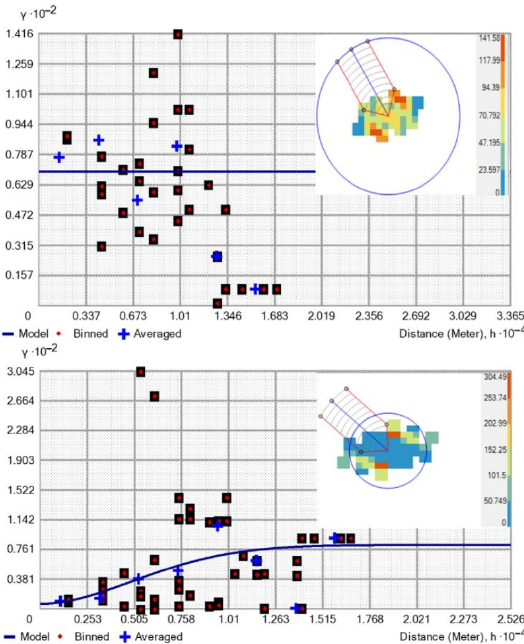
Figure 16. The empirical semivariograms with averaged values (fitted models by solid lines) and semivariogram maps of the ordinary kriging method from the dataset for the vegetation season ( top ) and heating season ( bottom ).